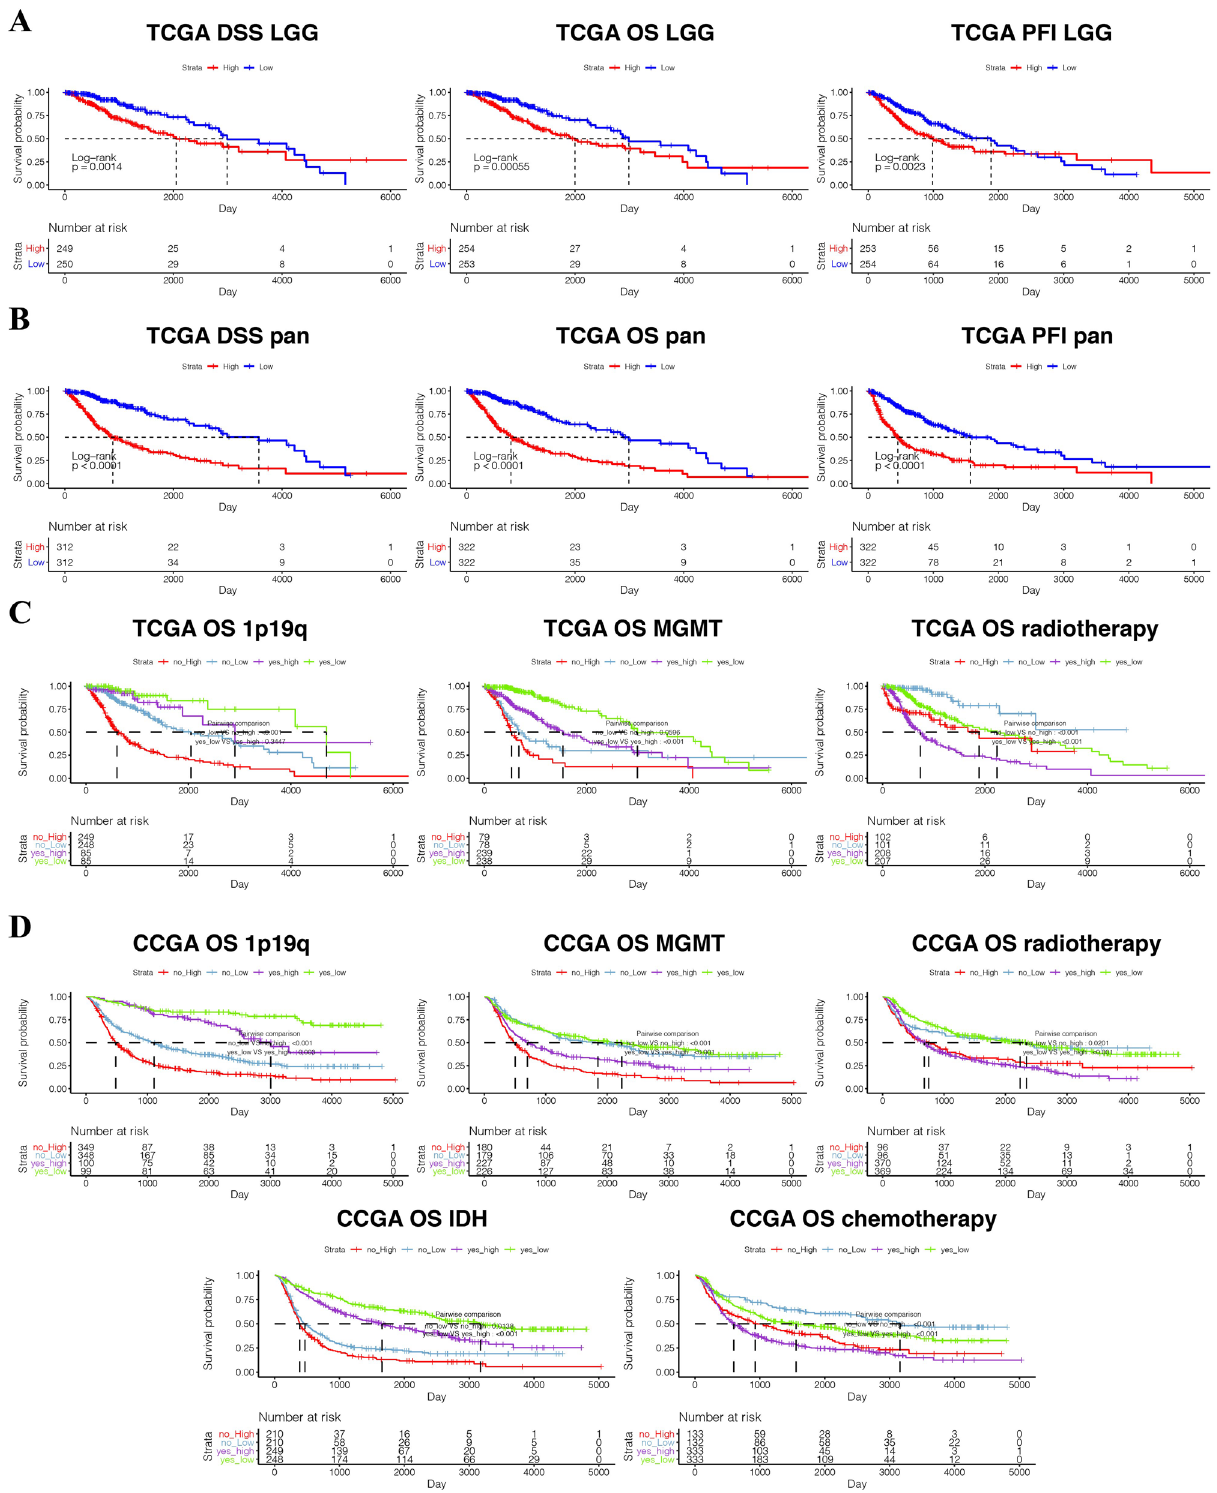
Figure 2. B2M expression is associated with poor survival in glioma patients. Kaplan–Meier analysis of overall survival (OS), disease specific survival (DSS), and progression-free interval (PFI) based on B2M expression were performed in LGGs ( A ) and pan-gliomas ( B ) from TCGA. Kaplan–Meier analysis of OS based on B2M expression in different prognostic factors including 1p19q, MGMT, radiotherapy, IDH, chemotherapy was performed in TCGA ( C ) and CGGA ( D